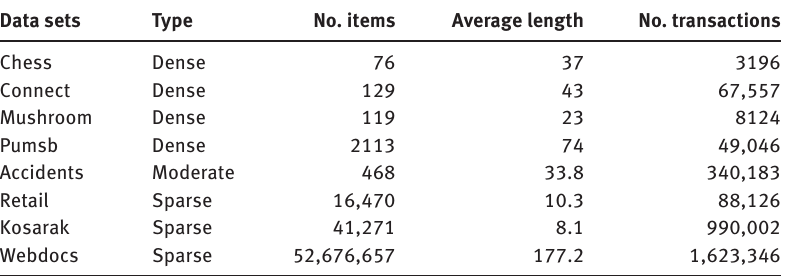
Table 4. Data Sets and Their Properties.